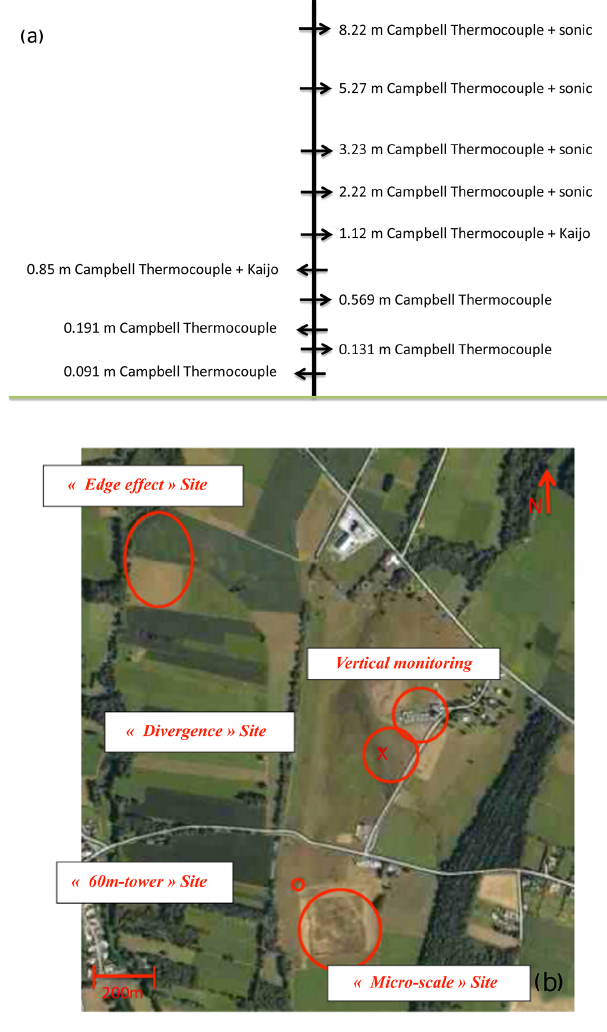
Figure 1. (a) Sketch of the distribution of sensors that were de- ployed on the 10m mast during BLLAST and (b) an aerial view of the site (the red X indicates the location of the 10m